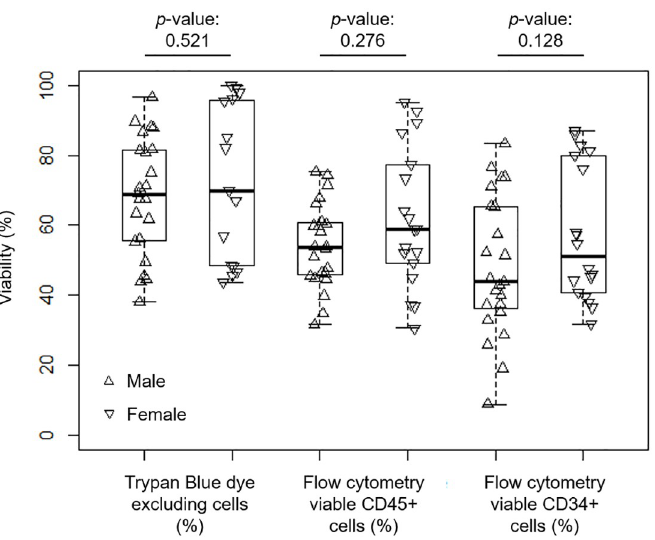
Fig 5. The comparative effect of patient gender on the immediate post-thaw viability of cryopreserved leukapheresis samples. Cell viability was determined as trypan blue exclusion or by flow cytometry for CD45+ and CD34+ cells. The p -values obtained from comparing means between patient gender are